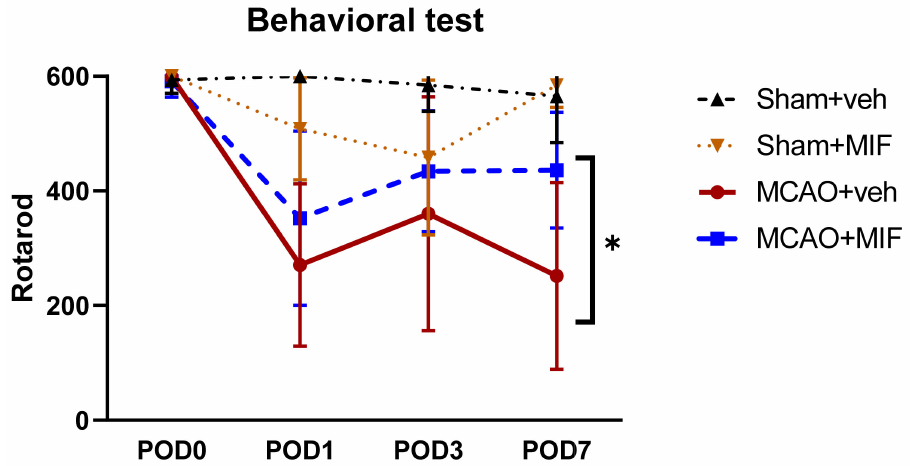
Figure 2. Rotarod latency. The Sham+veh ( n = 15) and Sham+MIF ( n = 15) groups both obtained scores of more than 500 in the rotarod test through all time points (POD0, 1, 3, 7). However, the score of mice that underwent MCA occlusion surgery decreased by POD 1. In the MCAO+veh group ( n = 14), the latency temporarily increased slightly at POD3 but decreased again at POD7. As in the MCAO+veh group, the MCAO+MIF group ( n = 14) exhibited a sharp decrease at POD1, but an increase occurred after MIF administration. The latency of MCAO+MIF was significantly higher compared to that in the MCAO+veh group (* p < 0.0001). Mean ± SD values are presented. The data were analyzed using one-way ANOVA, and post-analysis was performed using Tukey’s post hoc test. MCAO: middle cerebral artery occlusion; MIF: macrophage migration inhibitory